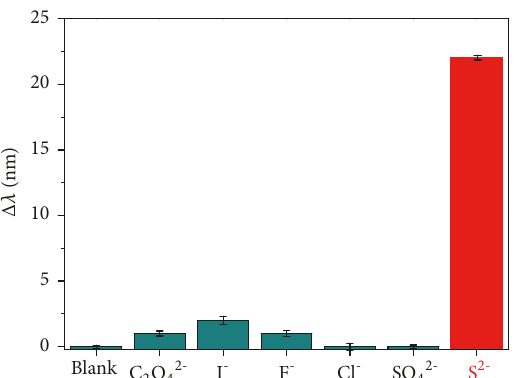
Figure 7: Selectivity of the Au-HgNRs sensing system for S 2− over several anions. The concentration of each anion was 5 × 10 −4 mol/L.